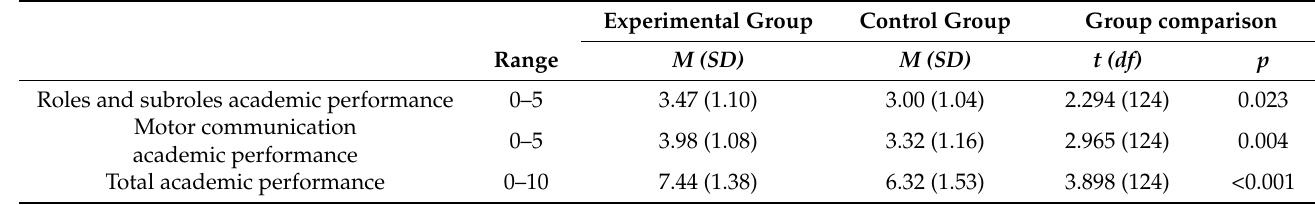
Table 2. Comparison between experimental and control groups.